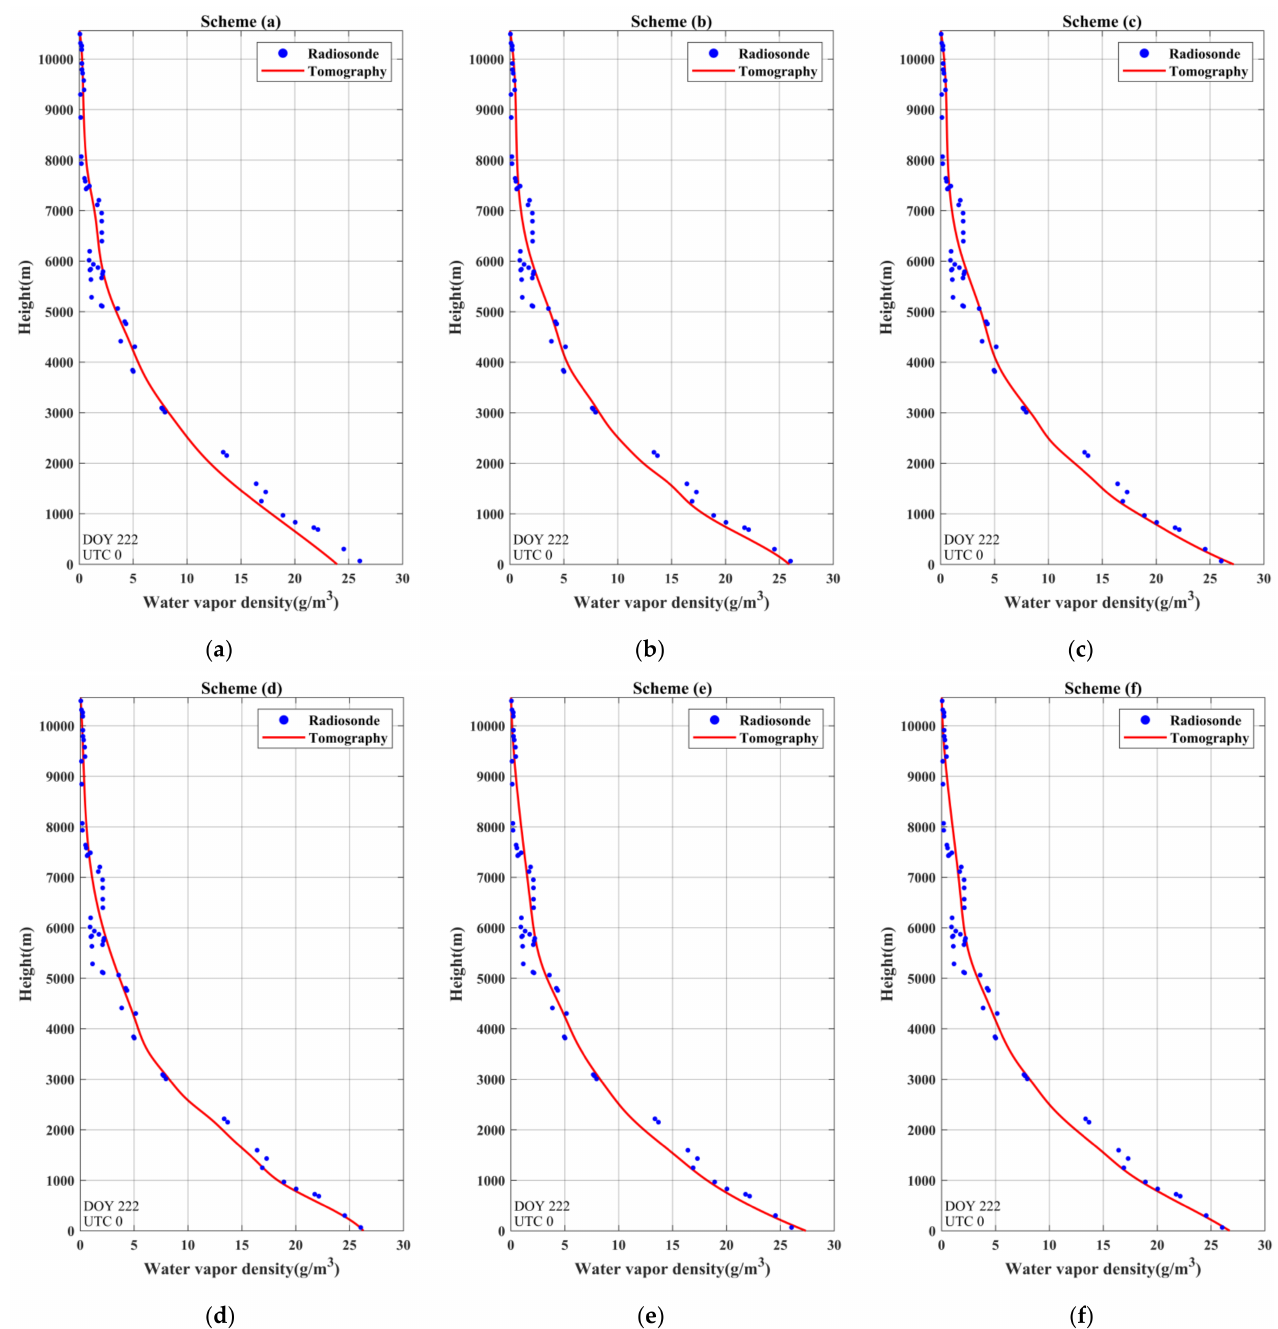
Figure 9. Comparison of water vapor density profiles derived from six schemes on DOY 222 at UTC 00:00. ( a ) Derived from uniform stratification; ( b – f ) derived from ANES with minimum height intervals of 350, 375, 400, 425 and 450 m,